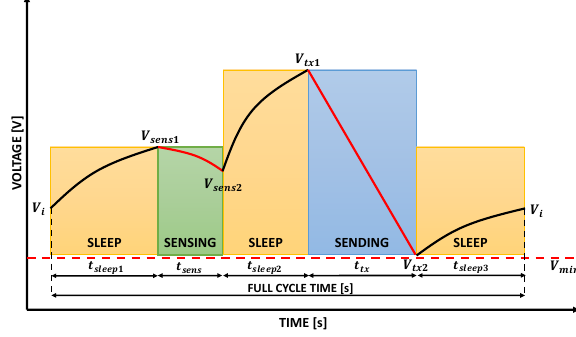
Figure 3. Sleep approach: LoRaWAN battery-less device sleeps between application